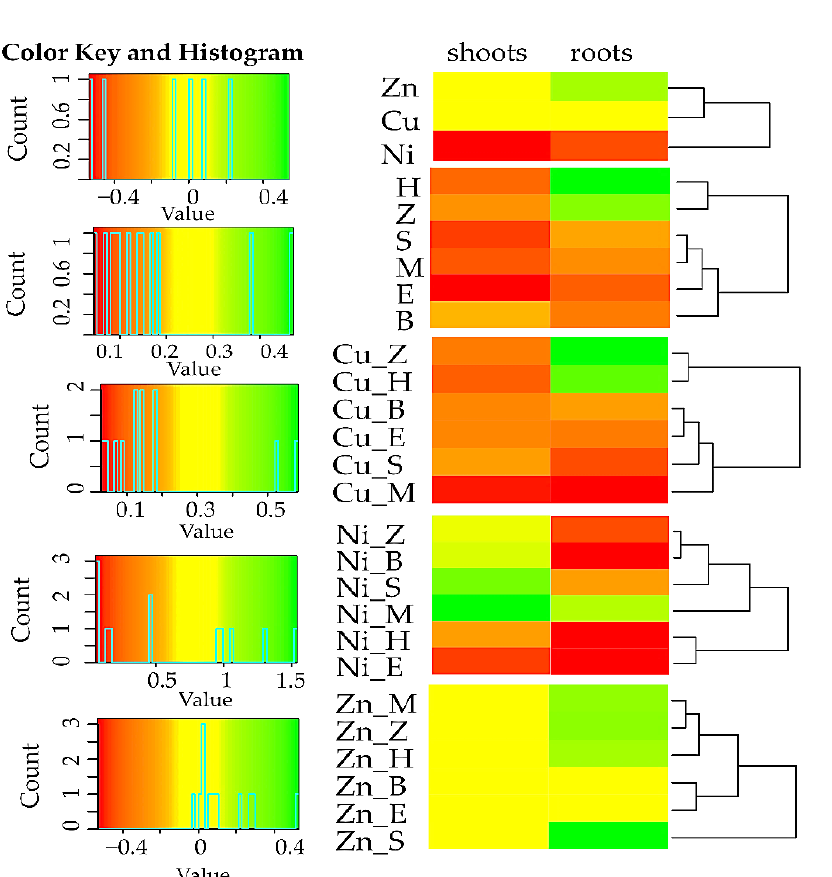
The abbreviations are explained under Table 1. Homogeneous groups were calculated separately for shoots (denoted with letters a–f) and roots (denoted with letters a–l), separately on average regardless of the metal used